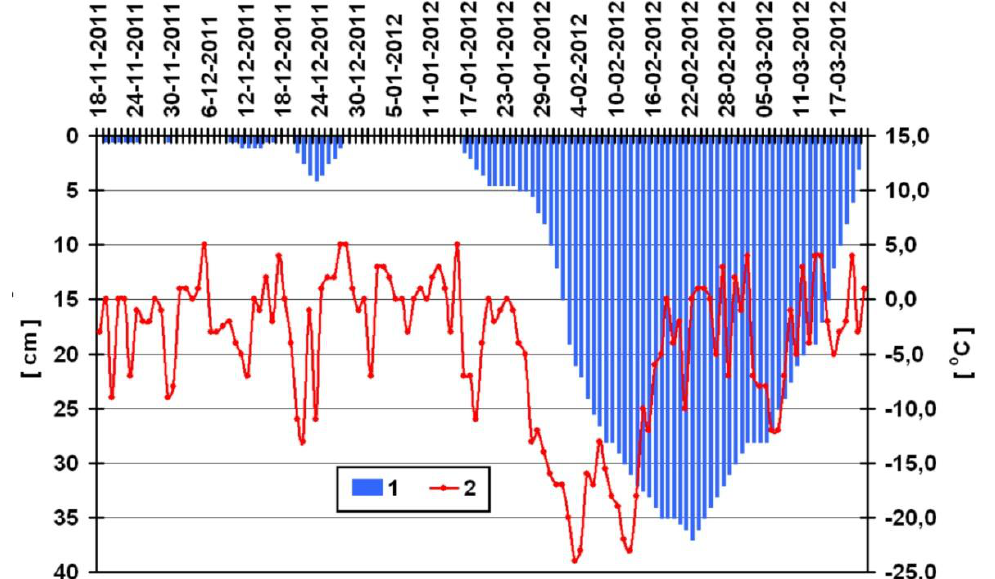
Fig. 3. Changes in the thickness of ice cover in the winter season 2011/2012 against the background of minimum air temperature at the ground 1 – thickness of compact ice cover; 2 – minimum temperature at the ground